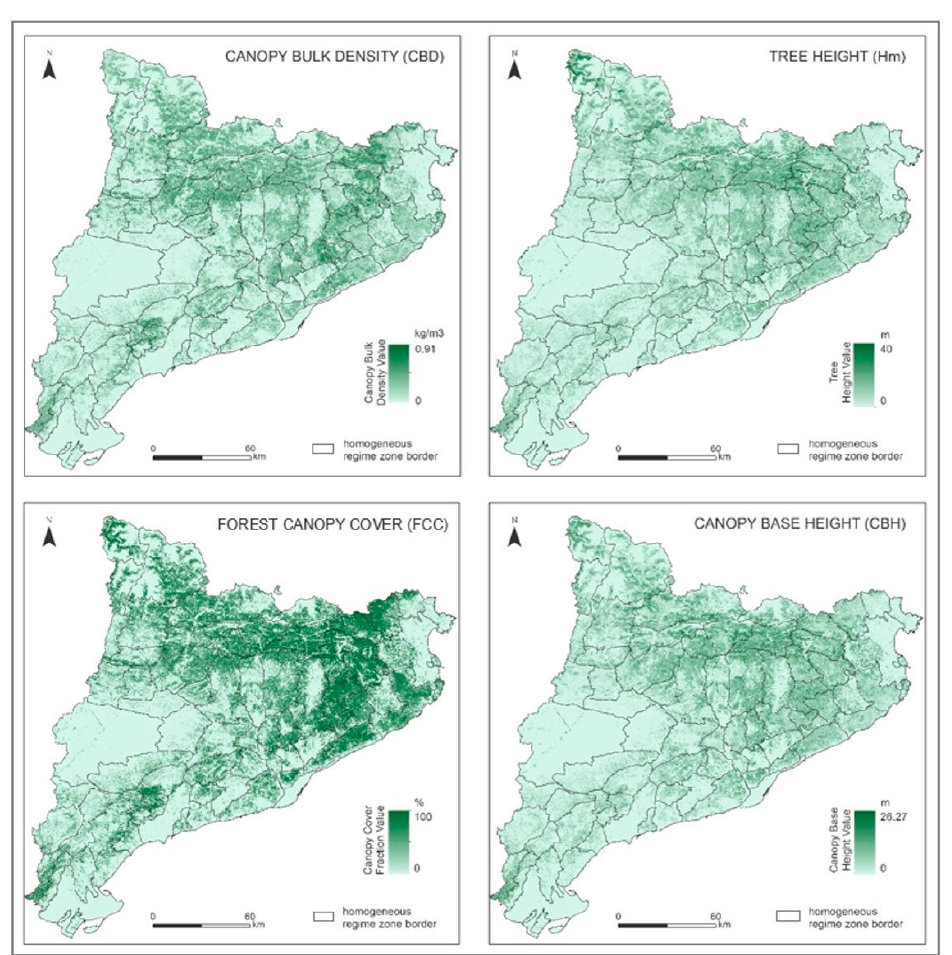
Figure 6. Biophysical variables of wooded forest areas in Catalonia contained in the landscape file of